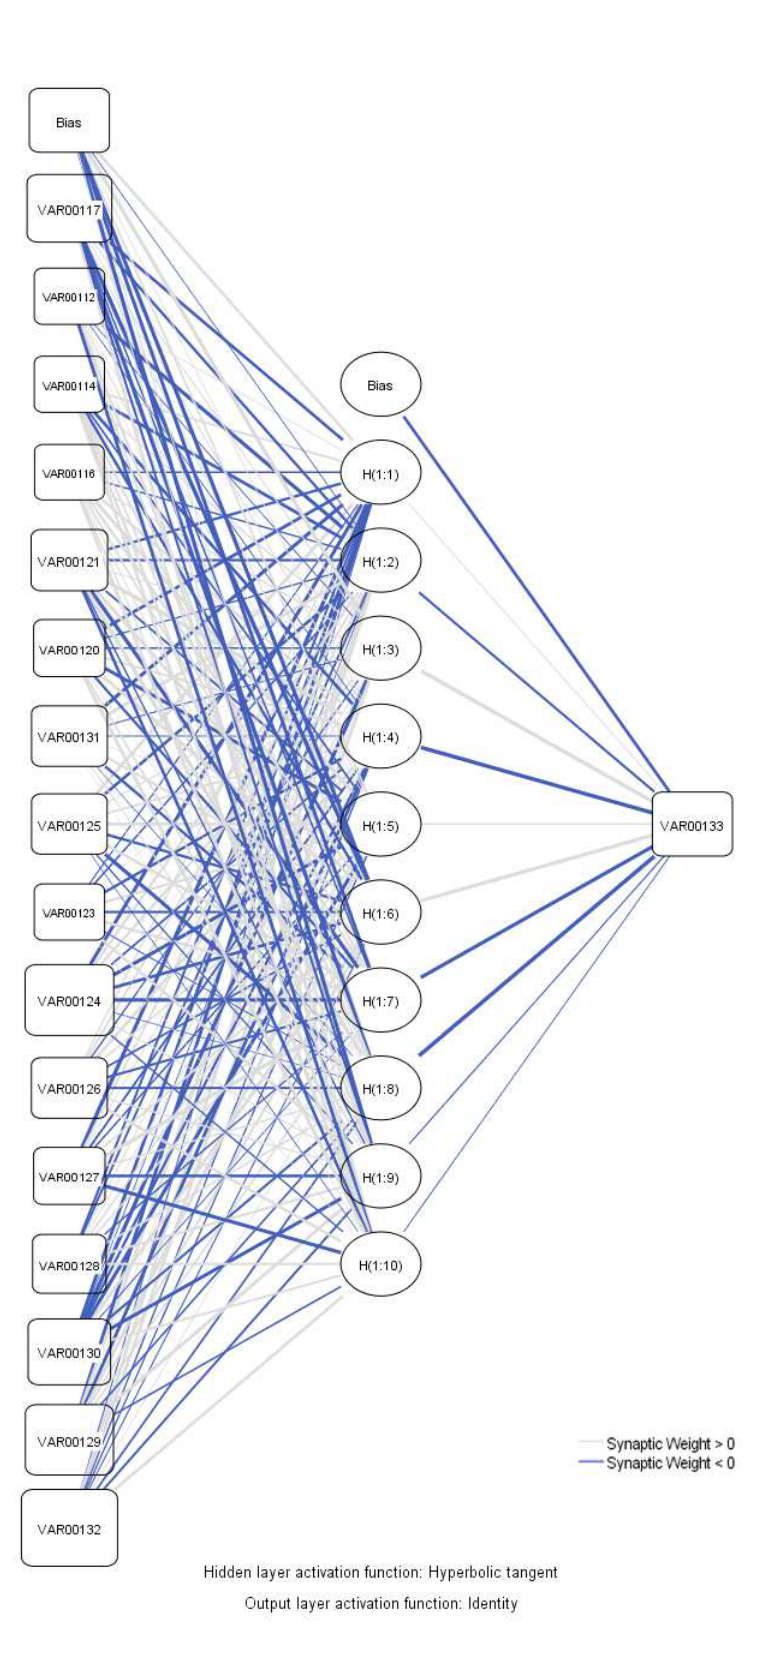
Figure 2. Simulated neural network